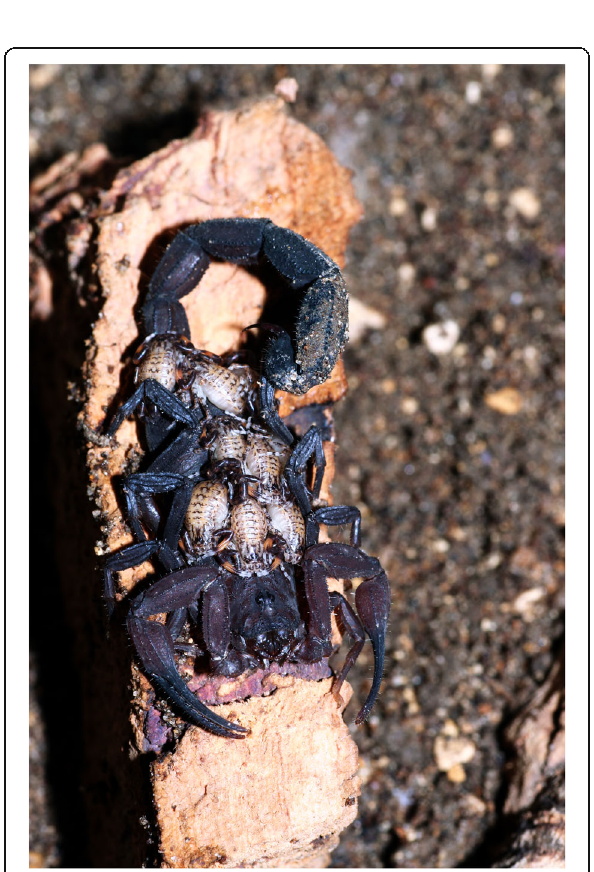
Fig. 19 Parthenogenetic female of Tityus neblina from the Tepui Neblina (Brazil-Venezuela) with first instar